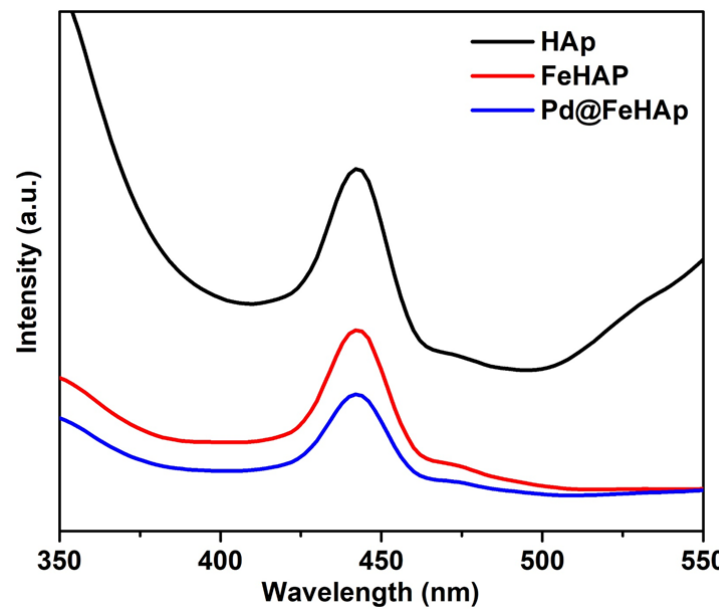
Figure 7. PL spectra of HAp, FeHAp, and Pd@FeHAp.